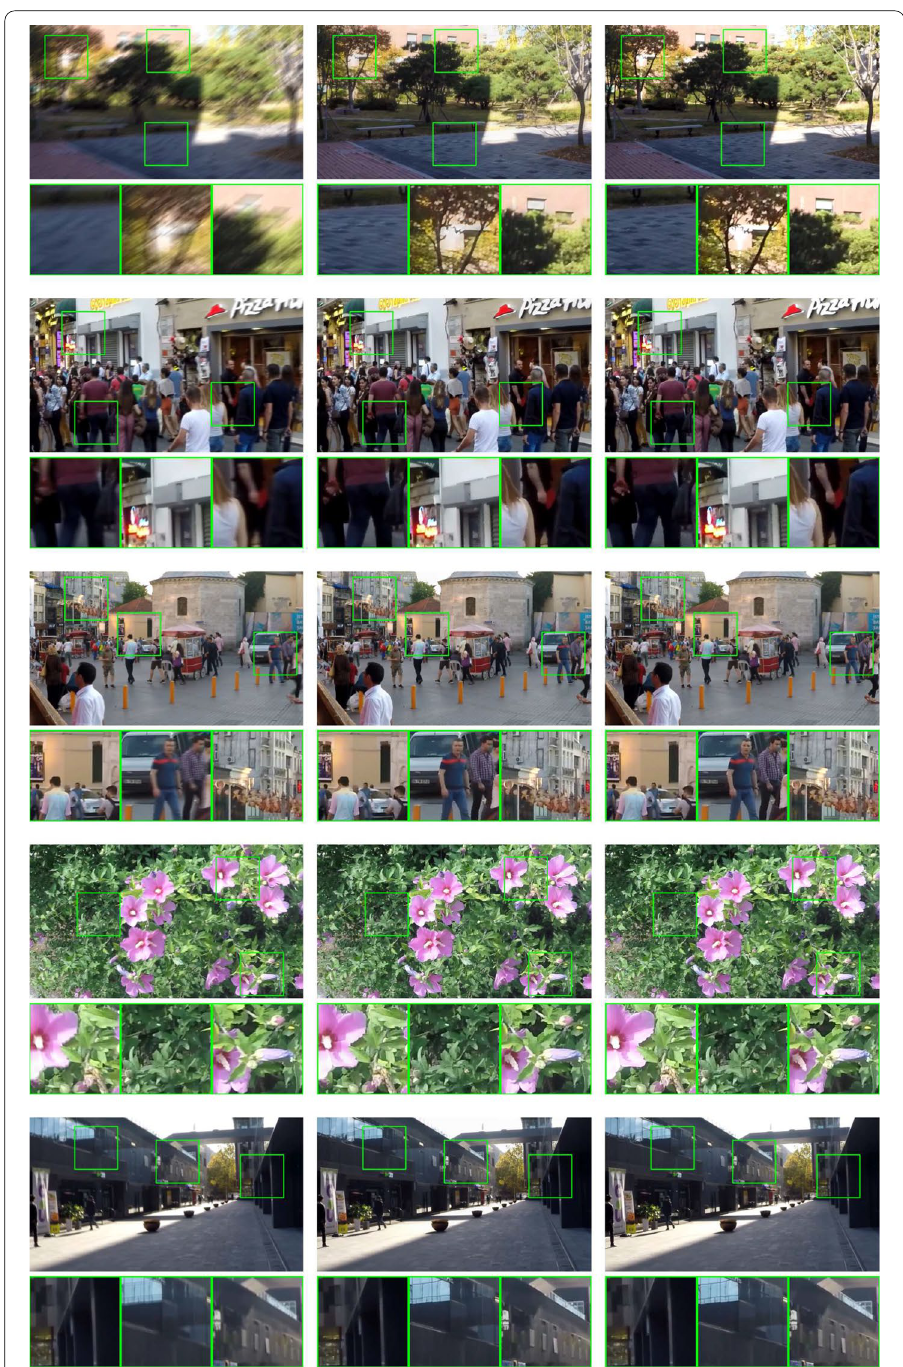
Fig. 5 Results on the GOPRO test dataset. From left to right: blurred, our deblurred, sharp photograph, all green small areas in the pictures in the above different scenes are randomly